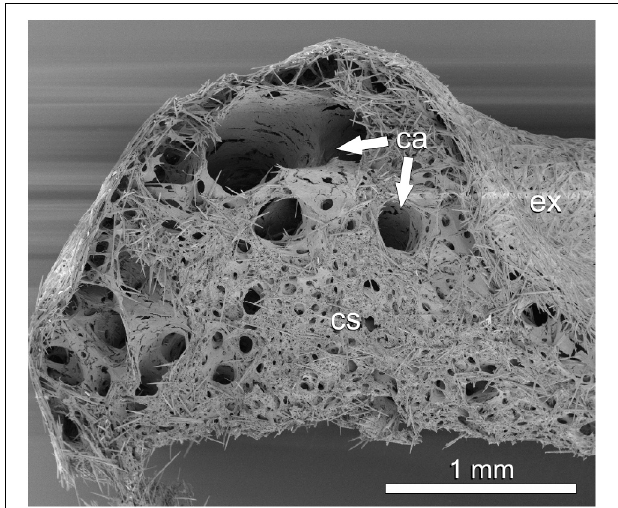
FIGURE 4 | Halichondria panicea , SEM, cryofracture. Overview of fracture surface of an expanded explant. Legend: ca: canals, cs: choanosome, ex: